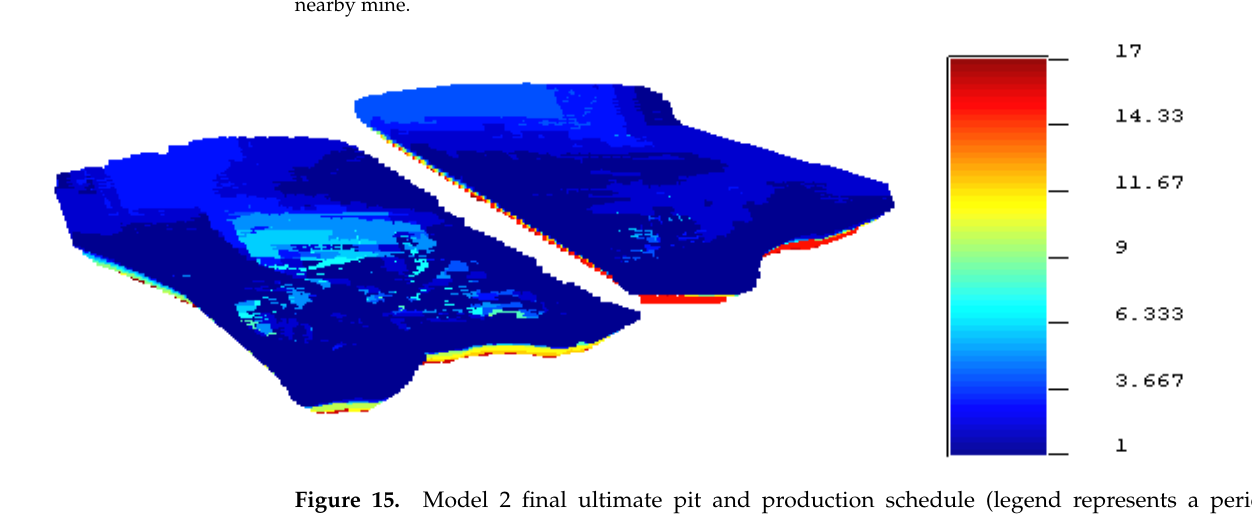
Figure 14. Model 2 MgO values from the study mine and a nearby mine for 17 periods.